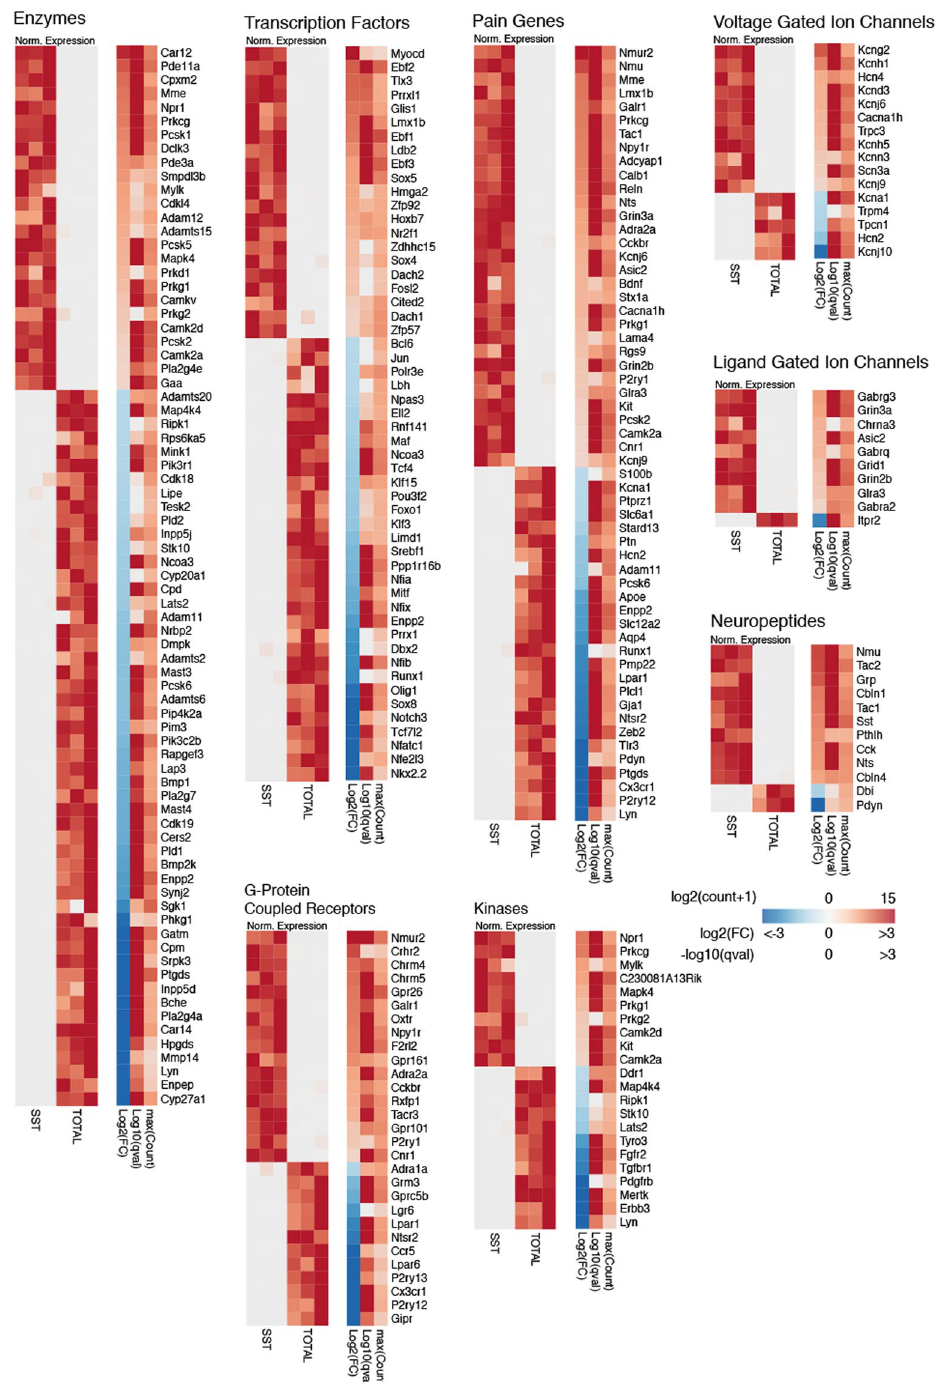
Figure 3. Enrichment of Genes from Selected Functional Classes in SST Neurons. Differential expression of genes in SST neurons compared to total dorsal horn nuclei grouped by functional classes. For each class, in the left heatmap, the expression level in each sample is normalized by the maximum expression level in the row (Norm. Expression). The right heatmap shows the log2-Fold Change (log2FC), − log10 of the q-value (adjusted p-value) and the log2 of the maximum value of counts for each gene plus a psuedocount of 1